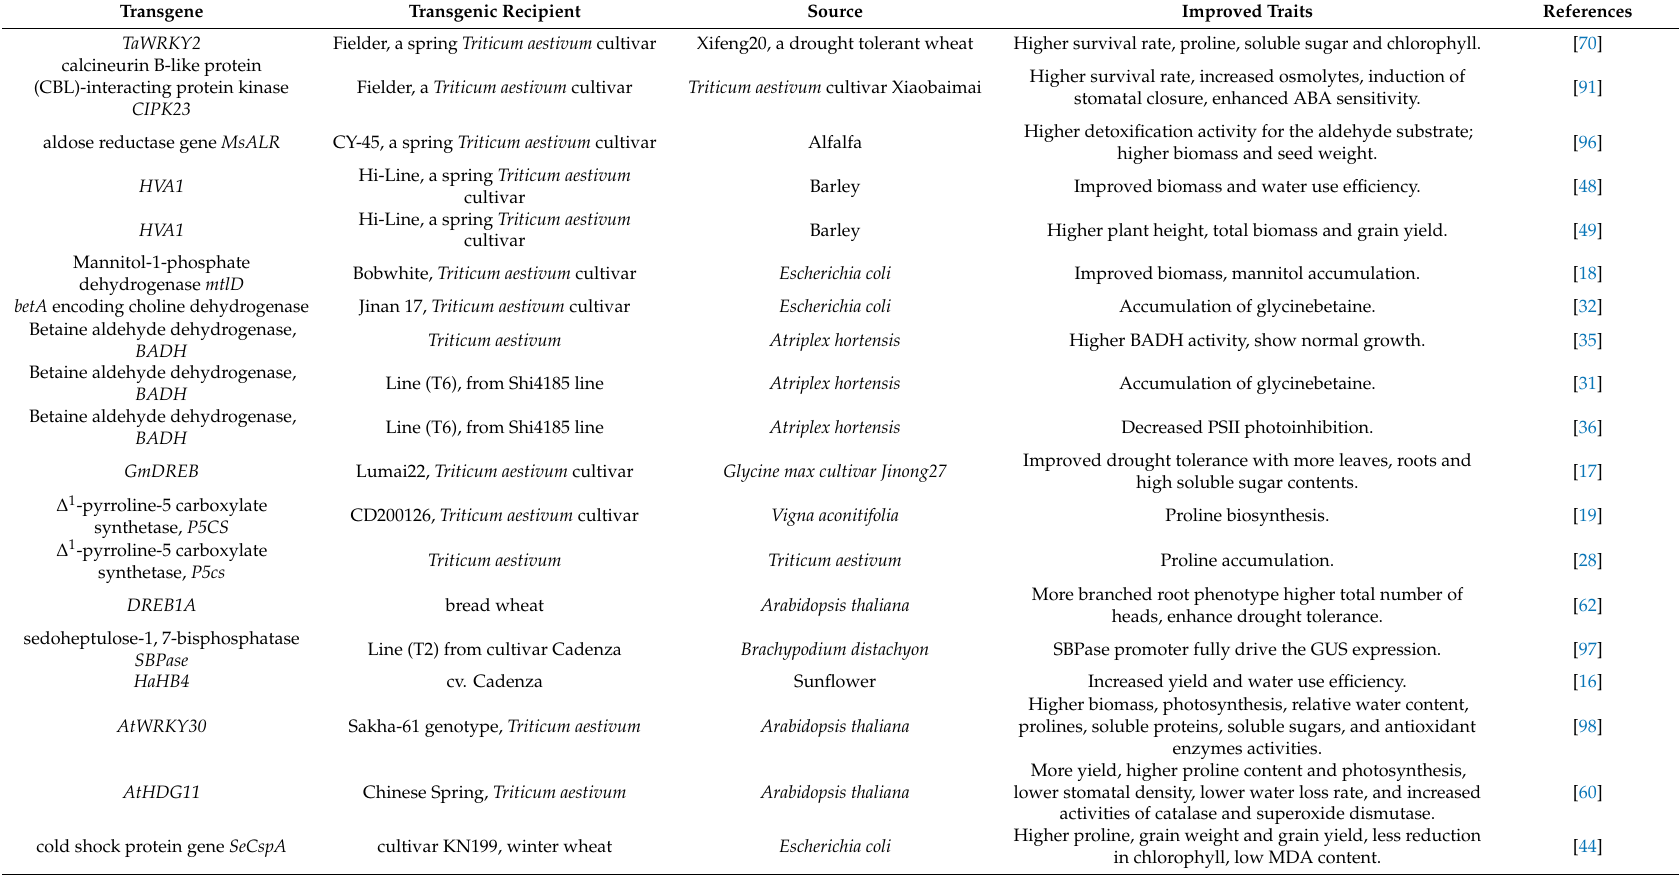
Table 1. Improving drought tolerance of wheat through engineering